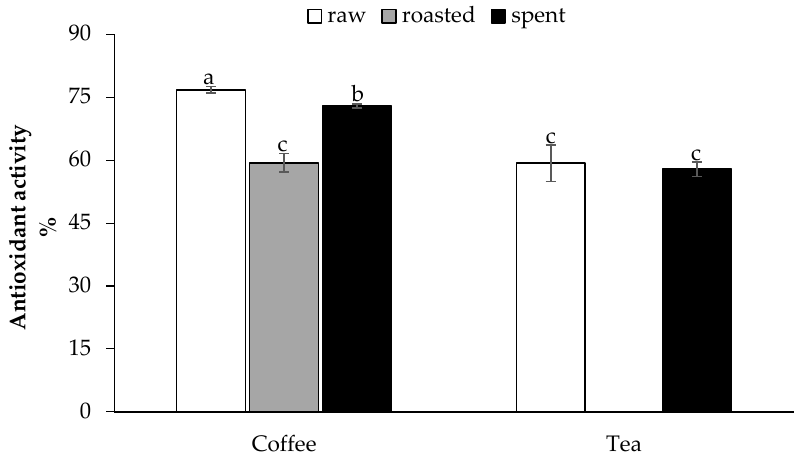
Figure 4. Antioxidant activity of spent coffee and black tea waste. Data represent the mean ± SD ( n = 3). a–c Means with different letters are significantly different ( p ≤ 0.05) as assessed by